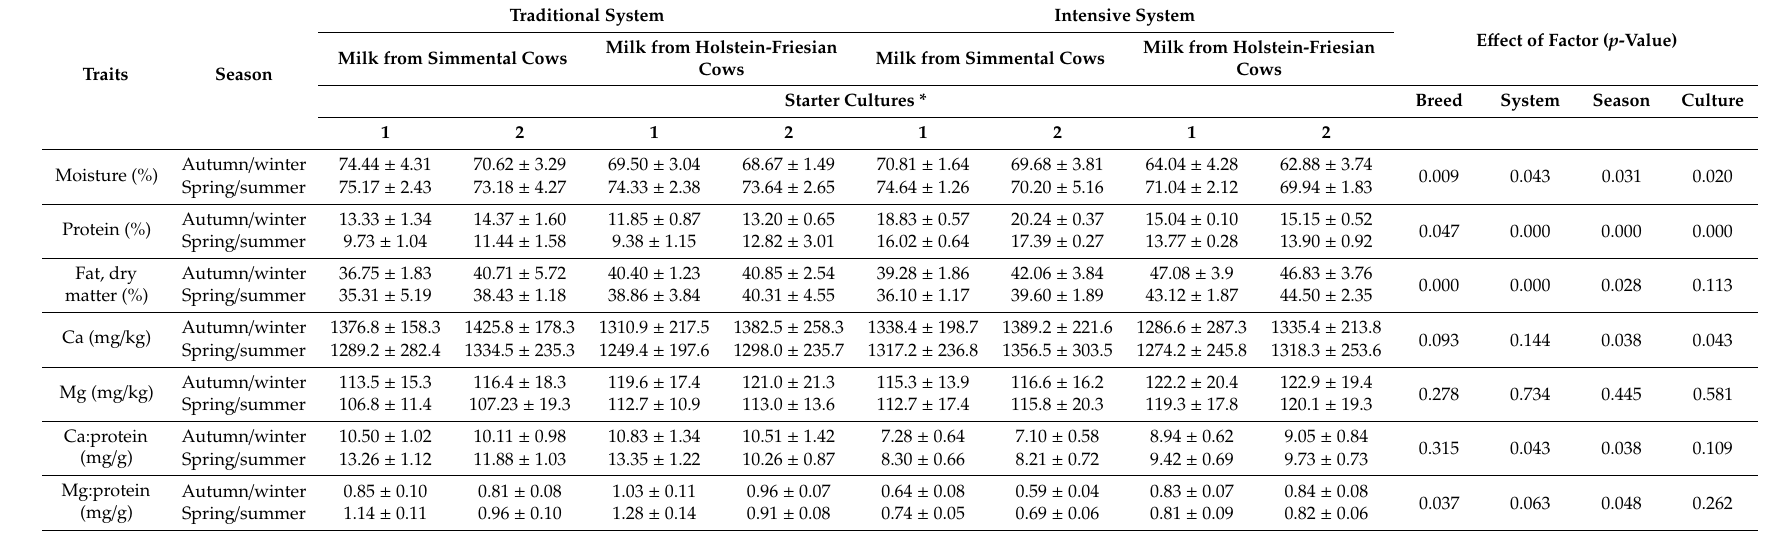
Table 2. Content of the basic chemical components and selected macro-elements in acid curd cheese (tvarog), depending on the experimental factors ( x ± SD).